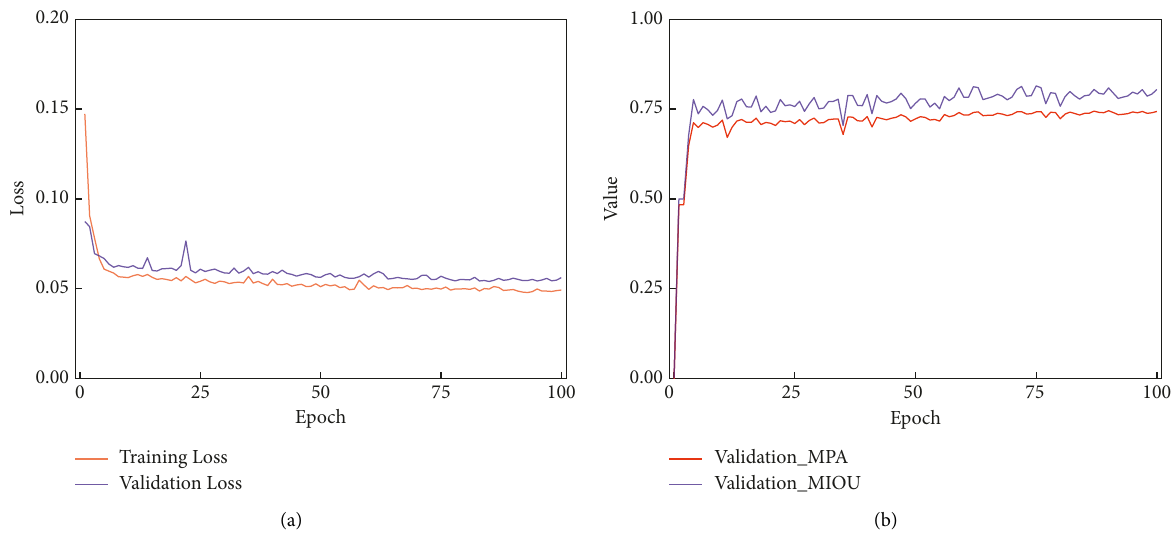
Figure 6: U-Net network structure.